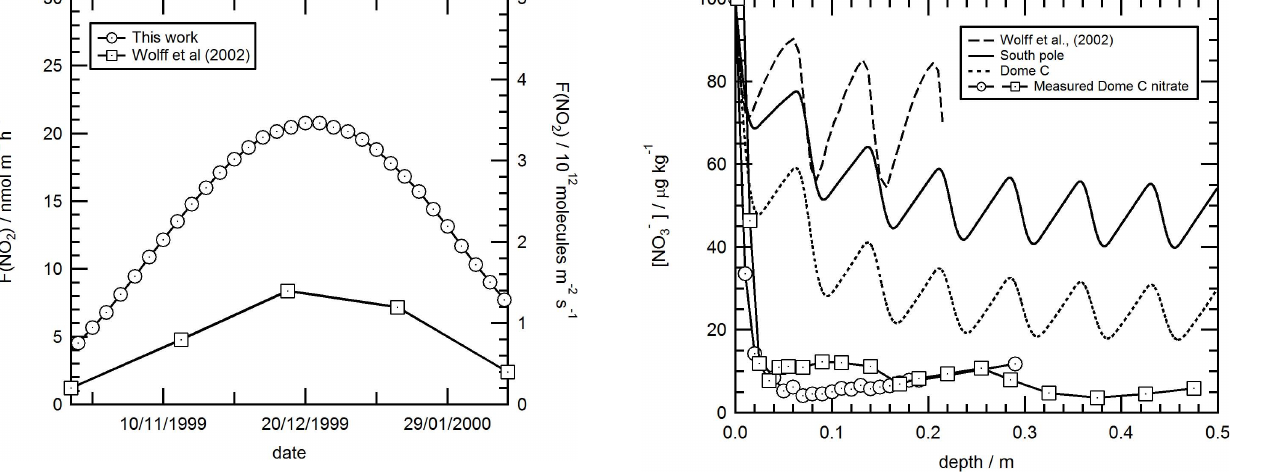
Fig. 7. Depletion of nitrate concentration with depth into the snow- pack due to only photolysis, assuming clear skies at South Pole and clear skies at Dome C, a Dome C accumulation rate (72 mmyr − 1 ) and a deposited nitrate concentration of 100µgkg − 1 continuously deposited year round. The nitrate concentration profile measured within the snowpack at Dome C was measured on 11 January 2010 and has been scaled to 100µgkg − 1 at the